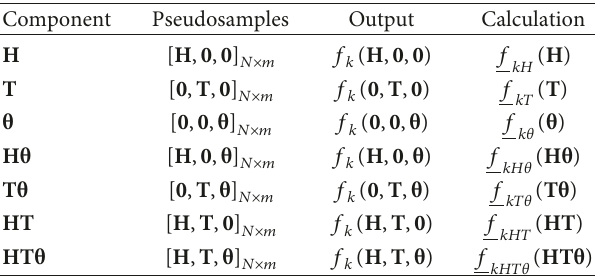
Figure 3: Schematic of influence components of dam environ- mental factors. Table 1: Component separation method of the KPLS model based on